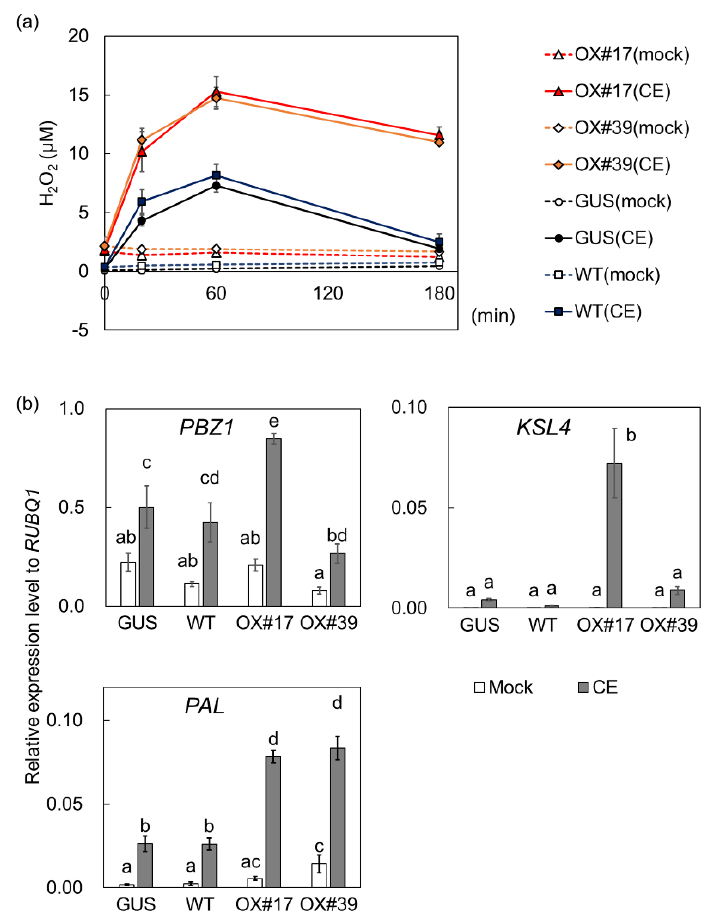
Figure 4. The overexpression of BSR1-HPB enhanced chitin-induced defense responses in suspension-cultured rice cells. Values are presented as the means ± standard deviations of three biological replicates. ( a ) H 2 O 2 concentrations were measured before treatment and at 20, 60, and 180 min after treatment. The statistical analysis was performed as shown in Figure S2b. Experiments were conducted three times with similar results. ( b ) The PBZ1 , PAL1 , and KSL4 transcript levels were normalized against the RUBQ1 internal control levels. Experiments were conducted twice with similar results. Di ff erent letters indicate significant di ff erences (Tukey’s test; p < 0.05). CE, chitin elicitor;